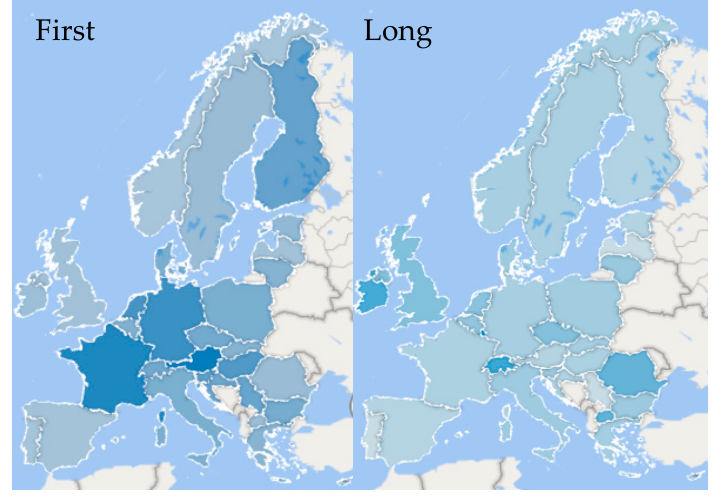
Figure 4. Number of precedencies by country—geospatial distribution.